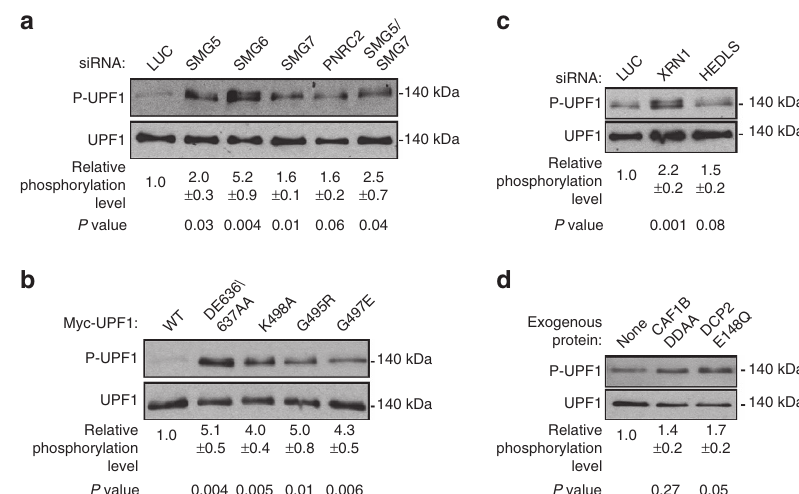
Figure 1 | Inhibition of UPF1 ATPase and disruption of decay activities increase UPF1 phosphorylation. ( a ) Western blots monitoring phosphorylation levels of endogenous UPF1 in HeLa tet-off cells transfected with indicated siRNAs followed by IP for UPF1 and anti-phospho-[S/T]Q (P-UPF1) and anti-UPF1 (UPF1) western blotting. Indicated phosphorylation levels were calculated from at least three independent experiments by dividing the P -UPF1 signal with that from anti-UPF1 (UPF1) and are shown normalized to control (LUC) conditions ± s.e.m. P values are indicated below panels and are relative to control conditions (paired two-tailed Student’s t -test). ( b ) Same as in a in HeLa tet-off cells transfected with myc-tagged UPF1 wild-type (‘WT’), ATP-hydrolysis mutant (DE636/637AA) or ATP-binding mutants (K498A, G495R and G497E). Indicated phosphorylation levels were calculated as in a and are shown normalized to control (‘WT’) conditions ± s.e.m. ( c ) Same as in a in HeLa tet-off cells transfected with indicated siRNAs. UPF1 phosphorylation levels were quantified as in a . ( d ) Same as in a in HeLa tet-off cells transfected with plasmids coding for myc-tagged UPF1 together with an empty vector (none) or vectors expressing CAF1B DDAA or DCP2 E148Q. UPF1 phosphorylation levels were quantified as in a and are shown normalized to control (‘none’) conditions ±